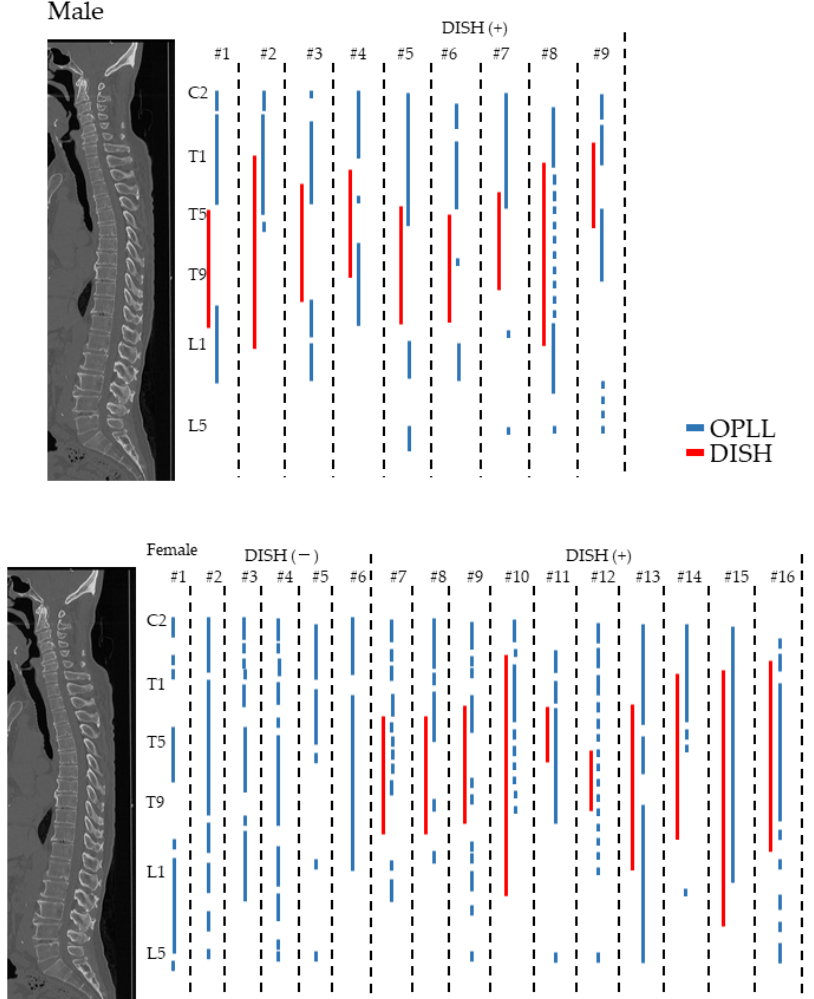
Figure 3. The distribution of OPLL and DISH in men and women in the high OP index group. DISH, diffuse idiopathic skeletal hyperostosis; OPLL, ossification of the posterior longitudinal ligament.